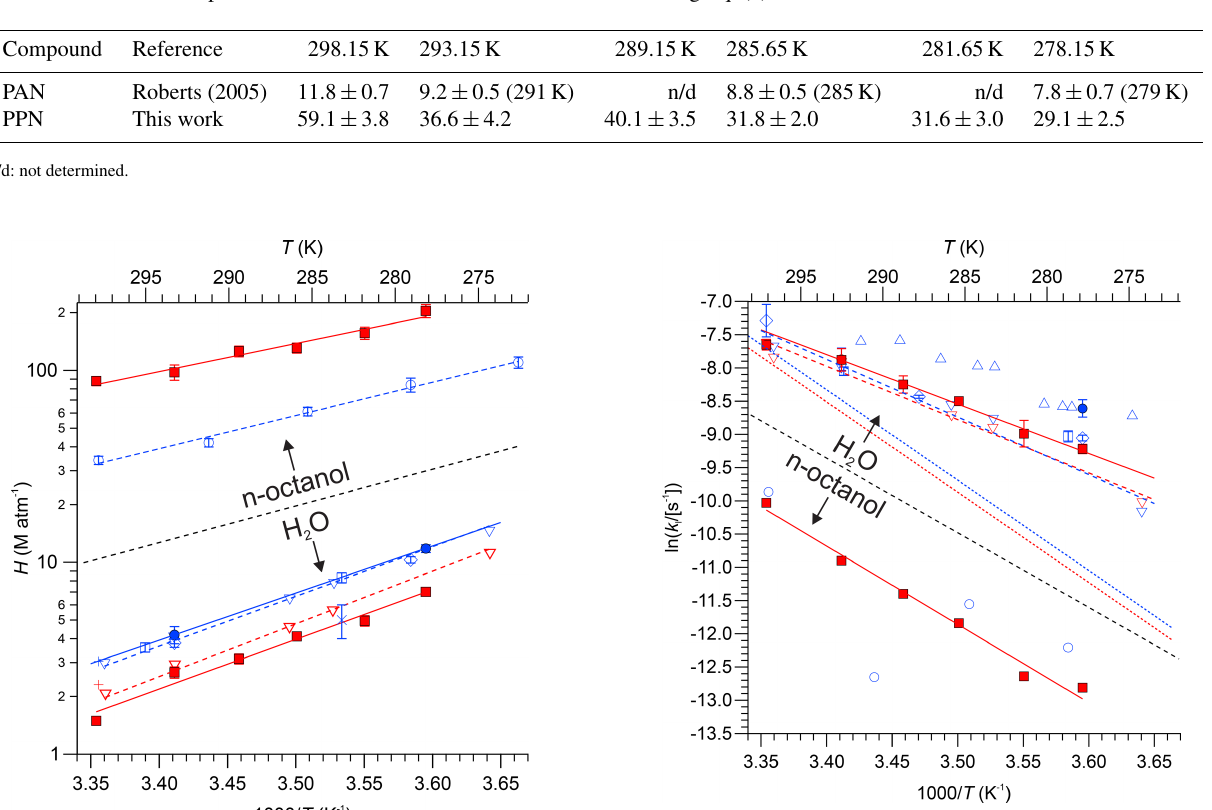
Figure 5. Henry’s law constants for PAN (blue colour) and PPN (red colour) in n -octanol and DI water as functions of tempera- ture. Data from this work are shown as solid symbols ( • for PAN and (cid:4) for PPN). Data from Fig. 6 of Kames and Schurath (1995) for PAN and PPN were extracted using “Engauge Digitizer” soft- ware (Mitchell et al., 2020) and are shown as (cid:79) and --. Other lit- erature data are shown as follows: (cid:3) Lee (1984), × Holdren et al. (1984), (cid:52) Kames et al. (1991), ♦ Frenzel et al. (2000), ◦ and -- Roberts (2005), + Raventos-Duran et al. (2010). The dashed black line serves as a visual indicator to separate results obtained with n - octanol (top portion of graph) from those obtained with DI water (bottom).